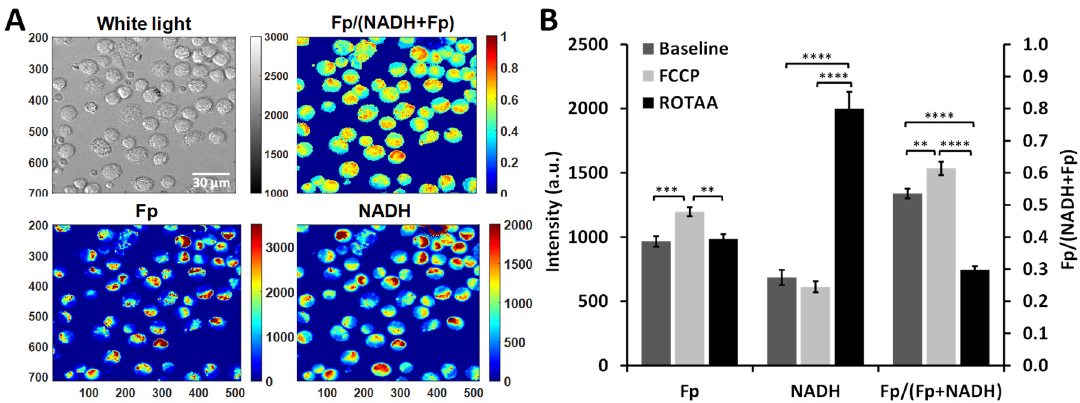
Figure 2. Optical redox imaging (ORI) of alveolar macrophages (AM) is sensitive to metabolic / redox perturbations. ( A ) Typical white light and redox images of AM from a female SP-A2 mouse (control group, filtered air (FA)-exposed). The grey / color bars to the right side of white light and the Fp and NADH images represent signal intensity in arbitrary units; whereas the color bar for the redox ratio Fp / (NADH + Fp) image represents the redox ratio ranging from 0 to 1. ( B ) Quantitative redox responses of AM from SP-A2 females to the metabolic perturbations by FCCP and ROTAA (Mean ± SD), confirming that ORI is sensitive to the redox changes under the experimental settings. ** p < 0.01, *** p < 0.001, and **** p < 0.0001.